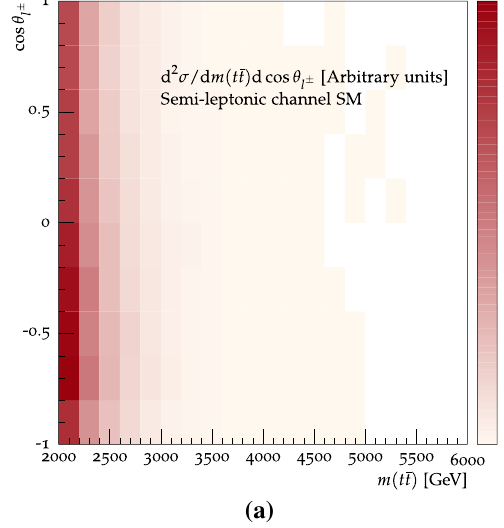
Fig. 3 Two-dimensional shape distributions of m ( t ¯ t ) and cos θ l ± for the expected SM background ( a ) and a narrow ( g t the semi-leptonic analysis. This corresponds to the worst-case scenario